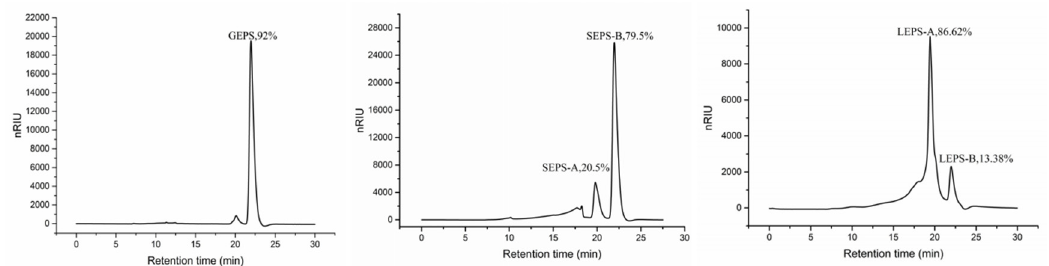
Figure 5. High performance liquid chromatography (HPLC) analysis of GEPS, SEPS, and LEPS.